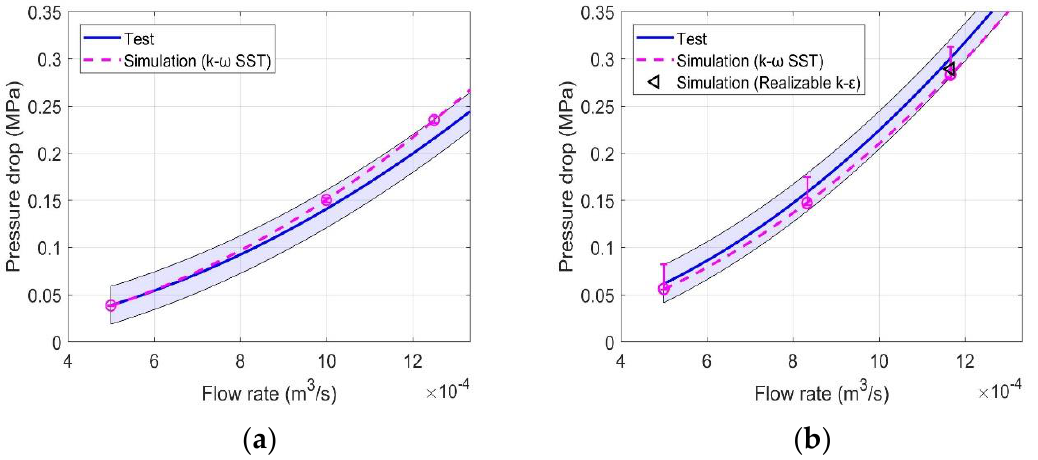
Figure 18. Comparison of simulation and test results for the mock-up equipped with MCs ( a ) and RRs ( b ). The shaded area represents the error band on the experimental results.